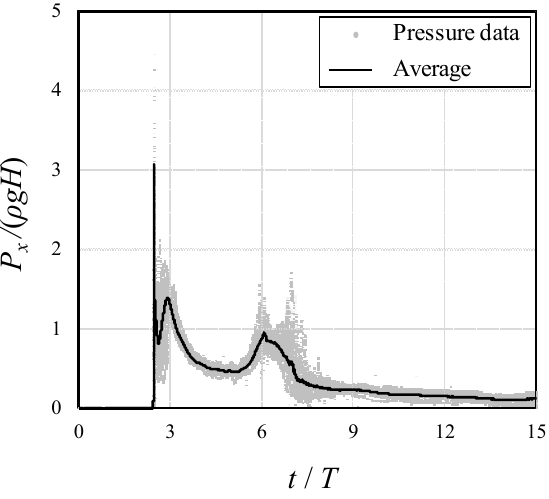
Figure 3. Time-history of the normalized pressure measured by Transducer 1. The gray area shows the cloud of data for 40 repetitions, and the solid curve represents the average pressure.